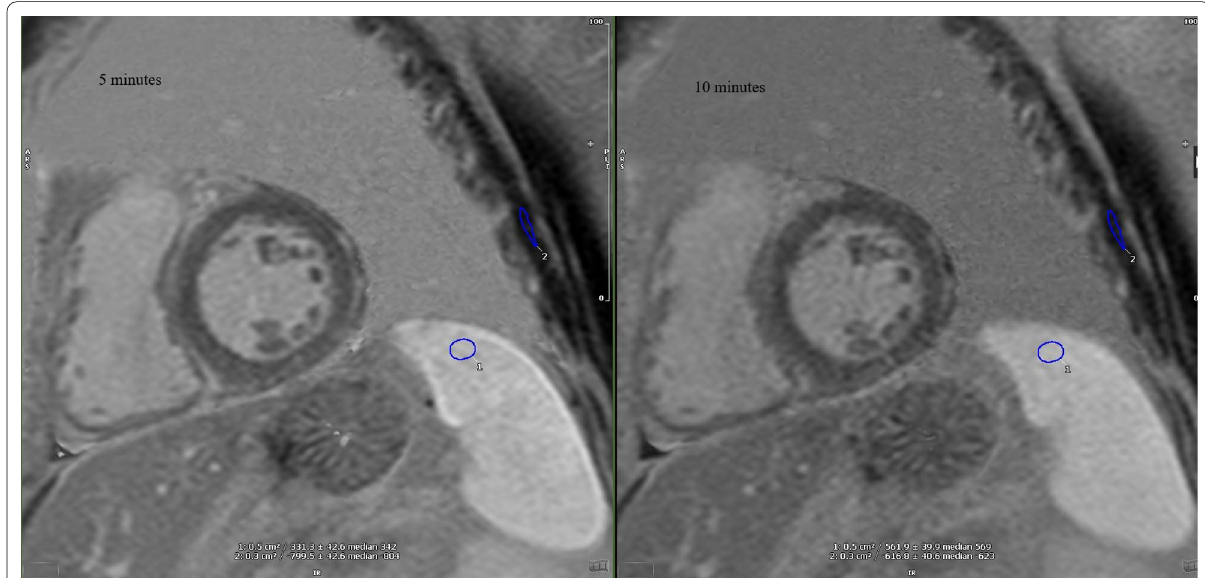
Fig. 1 Short-axis PSIR (phase sensitive inversion recovery) images at 5- and 10-min post contrast enhancement in patient with AL Amyloidosis. Regions of interest were drawn in the Spleen and adjacent Serratus anterior muscle, on both images, avoiding vessels, lesions, and artifacts. The “normalized” spleen ratio was defined as the calculated ratio of spleen values to the adjacent muscle